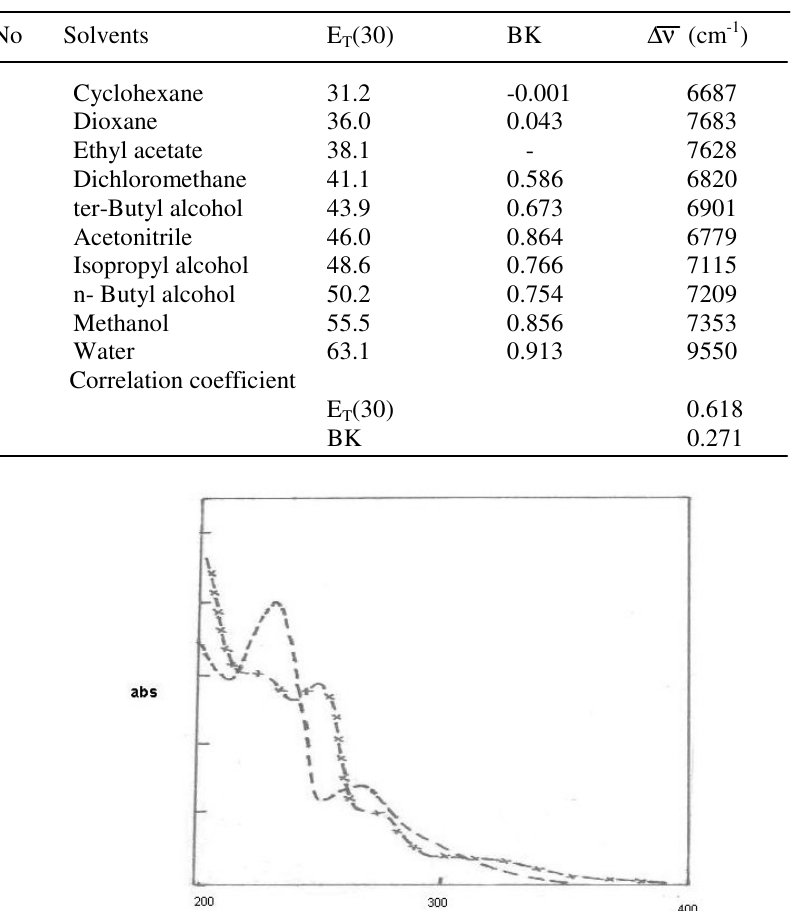
Figure 1 . Absorption spectra of different protoropic species of